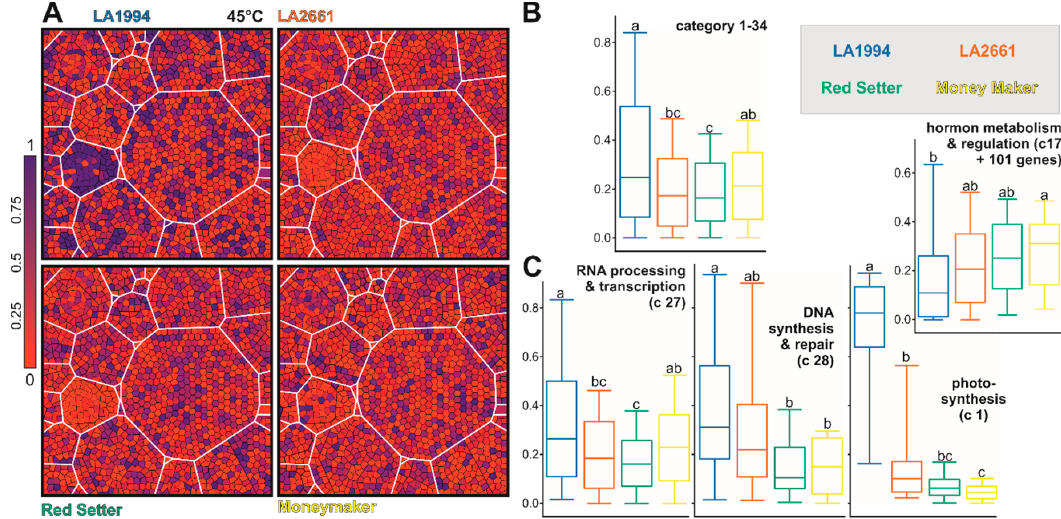
Figure 7. The genes contributing to PC1 and PC2 after 45 °C heat stress (HS) application. ( A ) The Voronoi Treemap as in Figure 5 of the transcript level for the indicated genotypes is shown. The coloring (shown on the left) indicates a lower (red) or higher transcript abundance (violet and blue) than expected for an equal transcript abundance in all genotypes (= 0.25). ( B , C ) Box plot representations of the distribution of the normalized transcript abundance values used in ( A ) for all genes (except not assigned; B ) or for all genes of the indicated MapMan categories ( C ) is shown. Statistical significance ( p < 0.05) of the difference was tested by One-Way ANOVA (Tukey). The color of the boxes accords to the color of the name in the legend.